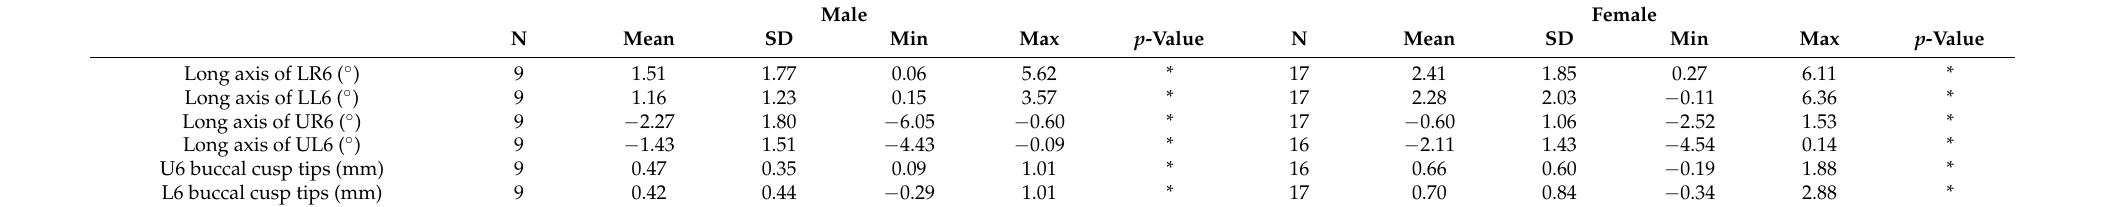
Table 3. Dental Transverse Changes Per Year in Males and Females (*, p <